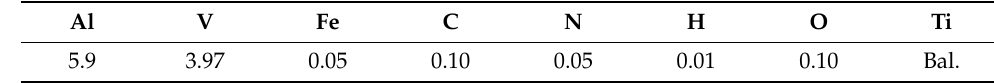
Table 2. Chemical composition of the Inconel 718 alloy wire (mass fraction,